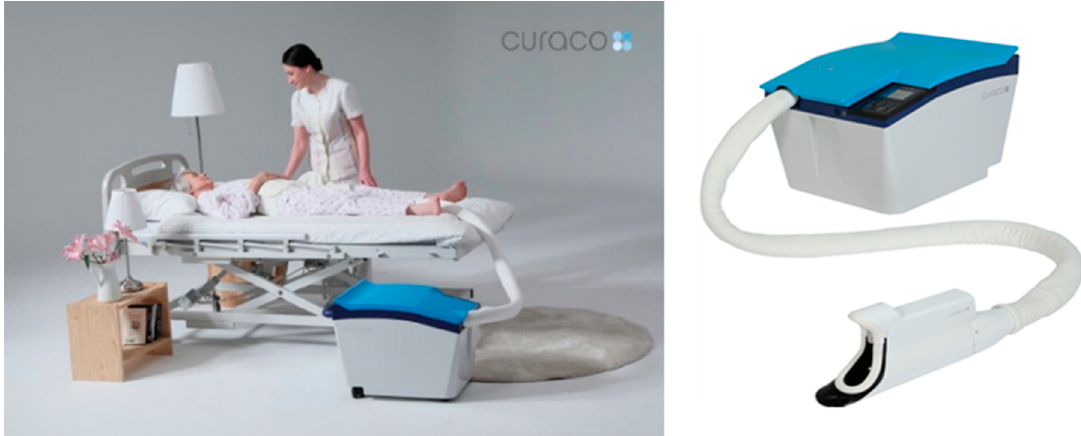
Figure 1. The excretion care robots: CareBidet. Reprinted with permission from Ref. [20]. 2018, CURACO. Table 1. The specifications of